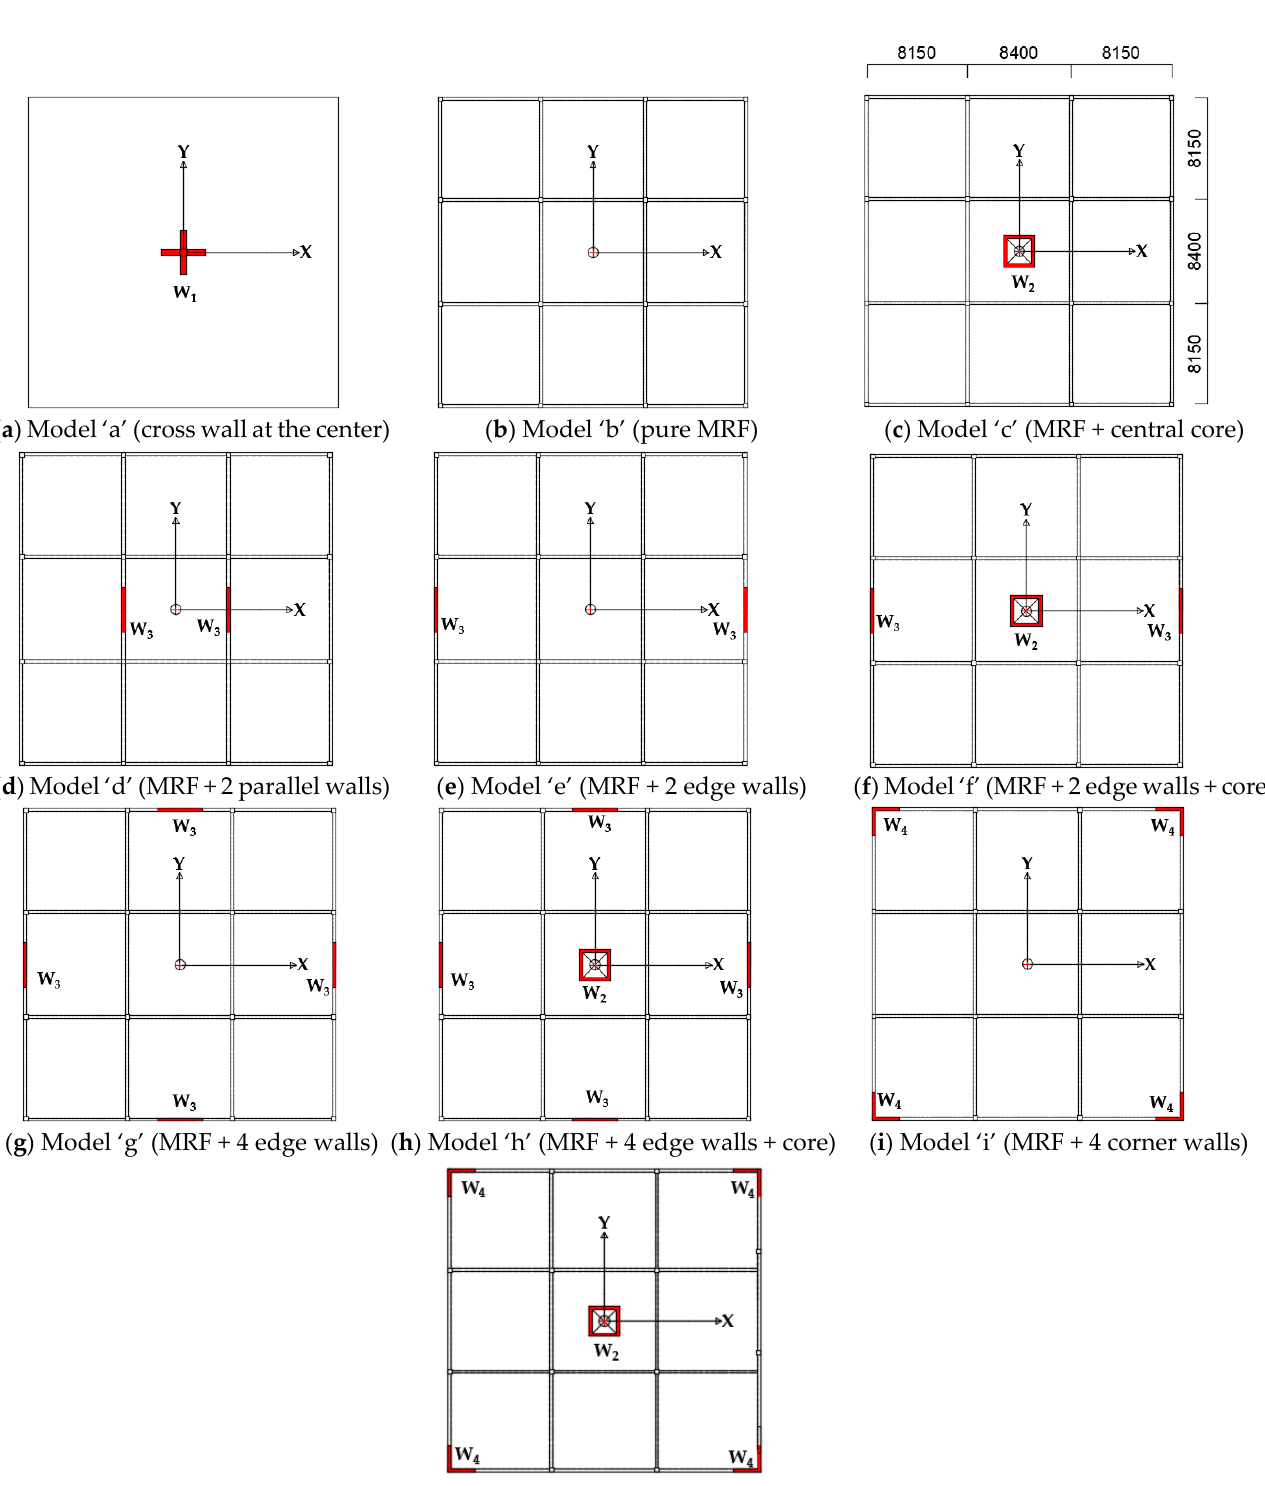
Figure 4. Floor plan and structural details of the symmetrical building models ‘a’ to ‘j’ used for the parametric study. The building dimensions of all the models are the same as the building dimensions provided for building model ‘c’.